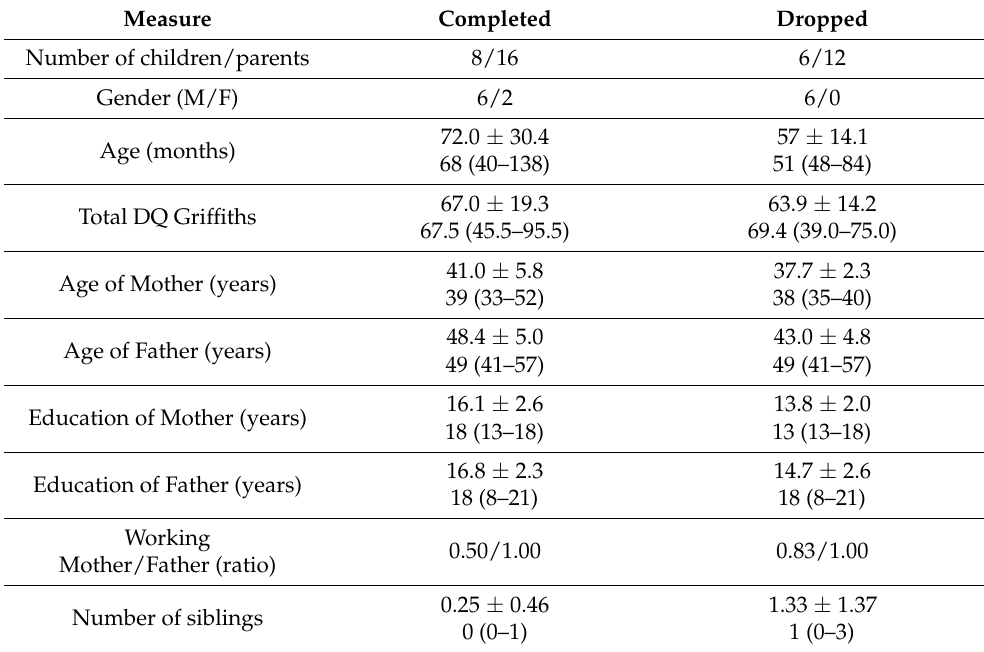
Table 3. Demographic and psychological characteristics of children with ASD and their parents.